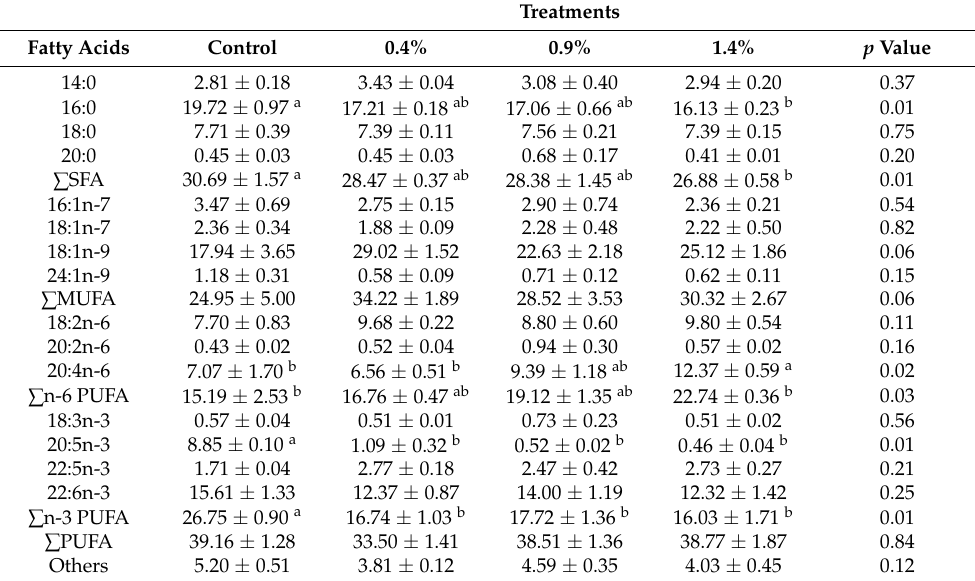
Table 5. Liver fatty acid composition (% of total FA) of S. dorsalis juvenile fed with different ARA concentrations.